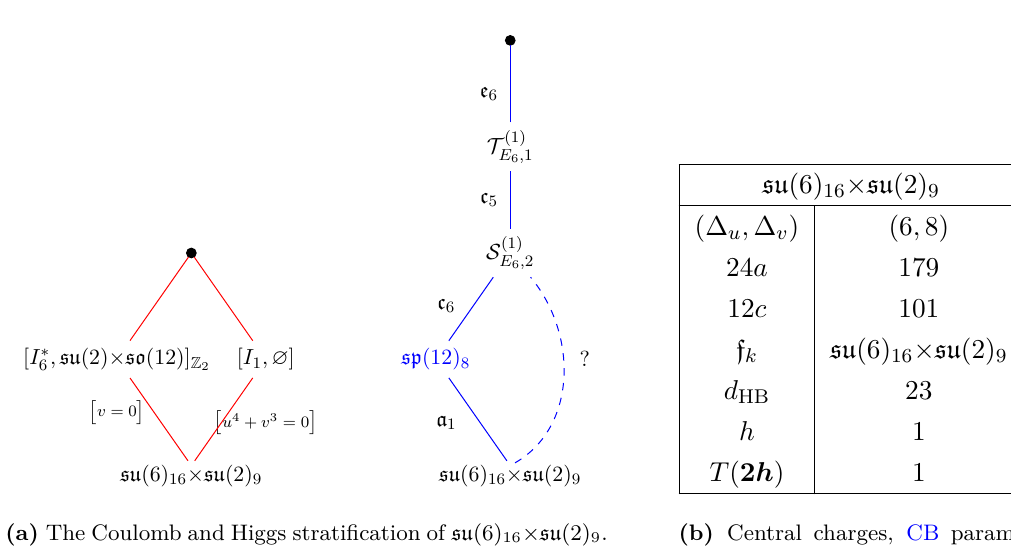
Figure 22. Information about the su (6) 16 × su (2) 9